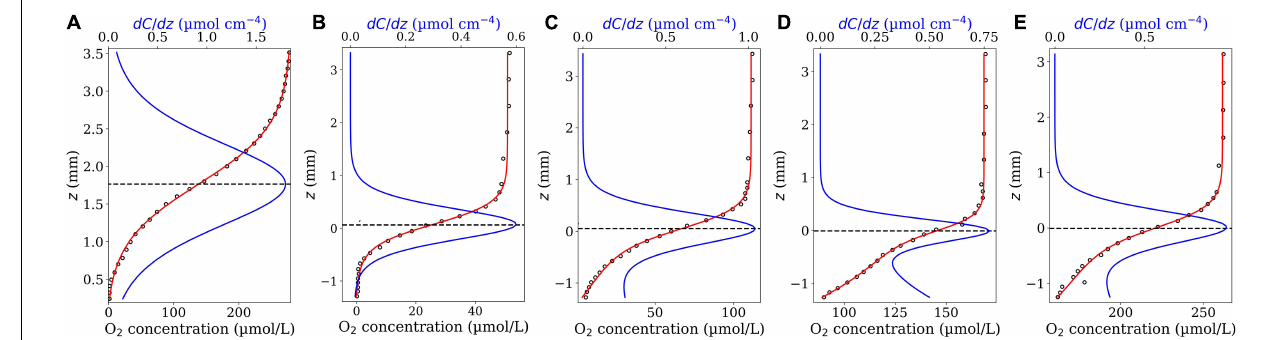
FIGURE 1 | Model validation. O2 concentration profiles (circle symbols) measured across the aggregate’s surface (from the ambient water down towards the aggregate’s center) within a representative N. spumigena aggregate (A) and a representative Skeletonema marioni aggregate exposed to different air saturation levels: 15% (B) , 40% (C) , 75% (D) and 100% (E) . The data shown in (A) and (B–E) were digitalized from Figure 2 in Klawonn et al. (2015) and Figure 1 in Stief et al. (2016), respectively. The z values obtained from Figure 1 in Stief et al. (2016) were multiplied by − 1 setting the positive direction of z -axis upwards. The red curves show the fitted model functions [Eq. 4 in (A) and Eq. 7 in (B–E) ] and the blue curves the corresponding first derivative functions. The horizontal dashed lines indicate the position of the interface on the z -axis, i.e., the position corresponded to the maximum value of the first derivative